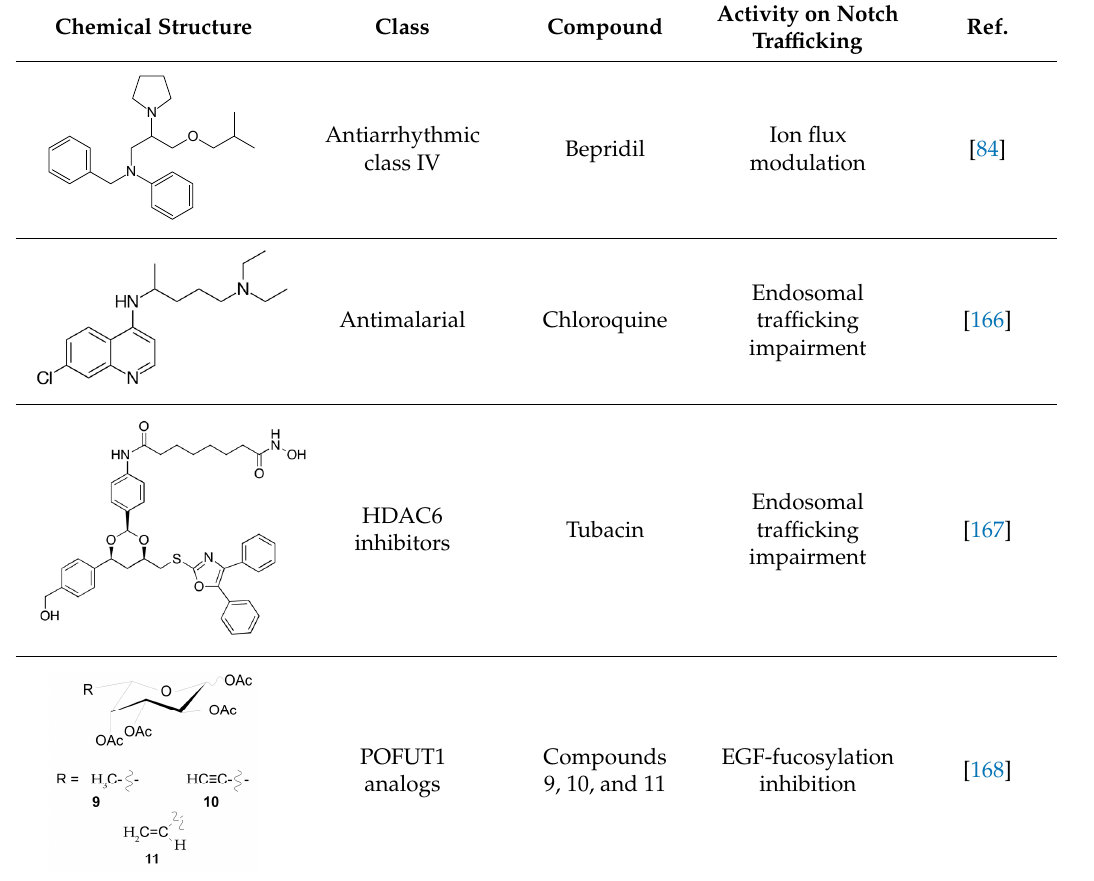
Table 1. Active compounds that target Notch tra ffi cking.